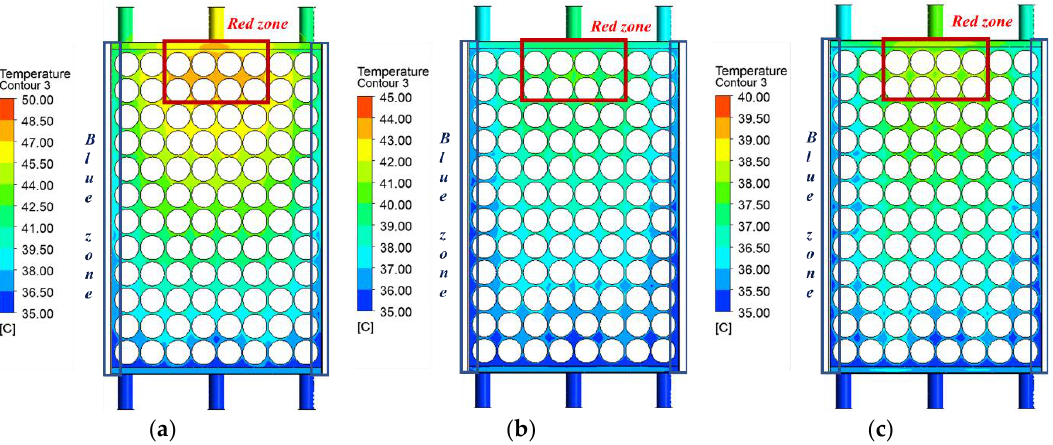
Figure 10. Temperature variation of battery module according to the flow rate under 35 °C outdoor air condition: ( a ) 1 lpm; ( b ) 3 lpm; ( c ) 5 lpm.